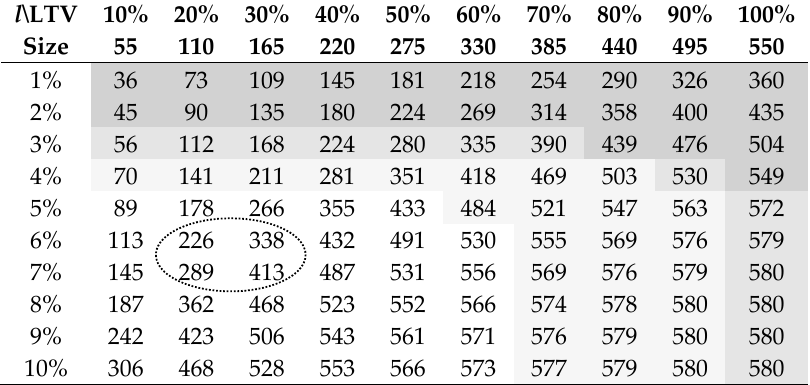
Table 1. Expected present values of the reverse mortgage under different loan interest rates and loan-to-value (LTV) ratios for a homeowner aged 65.